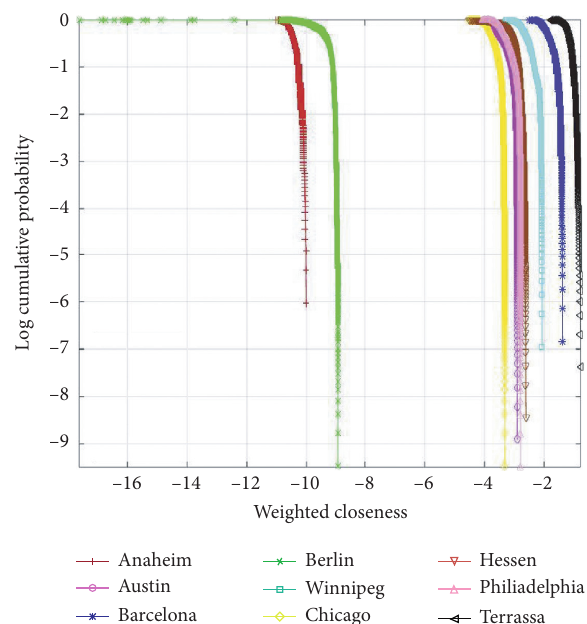
Figure 4: Weighted closeness centrality of URNs.